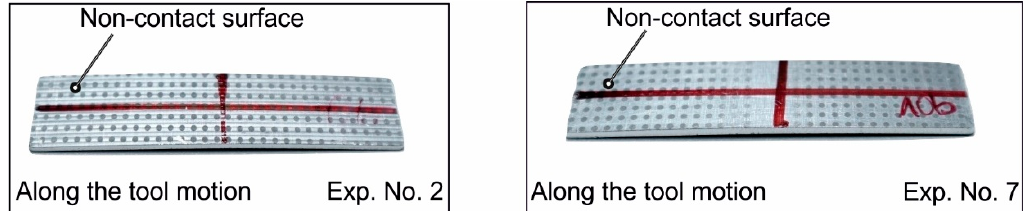
Figure 17. Curvature of the strips toward the lower surface. The contact side undergoes compression, and the non-contact side undergoes